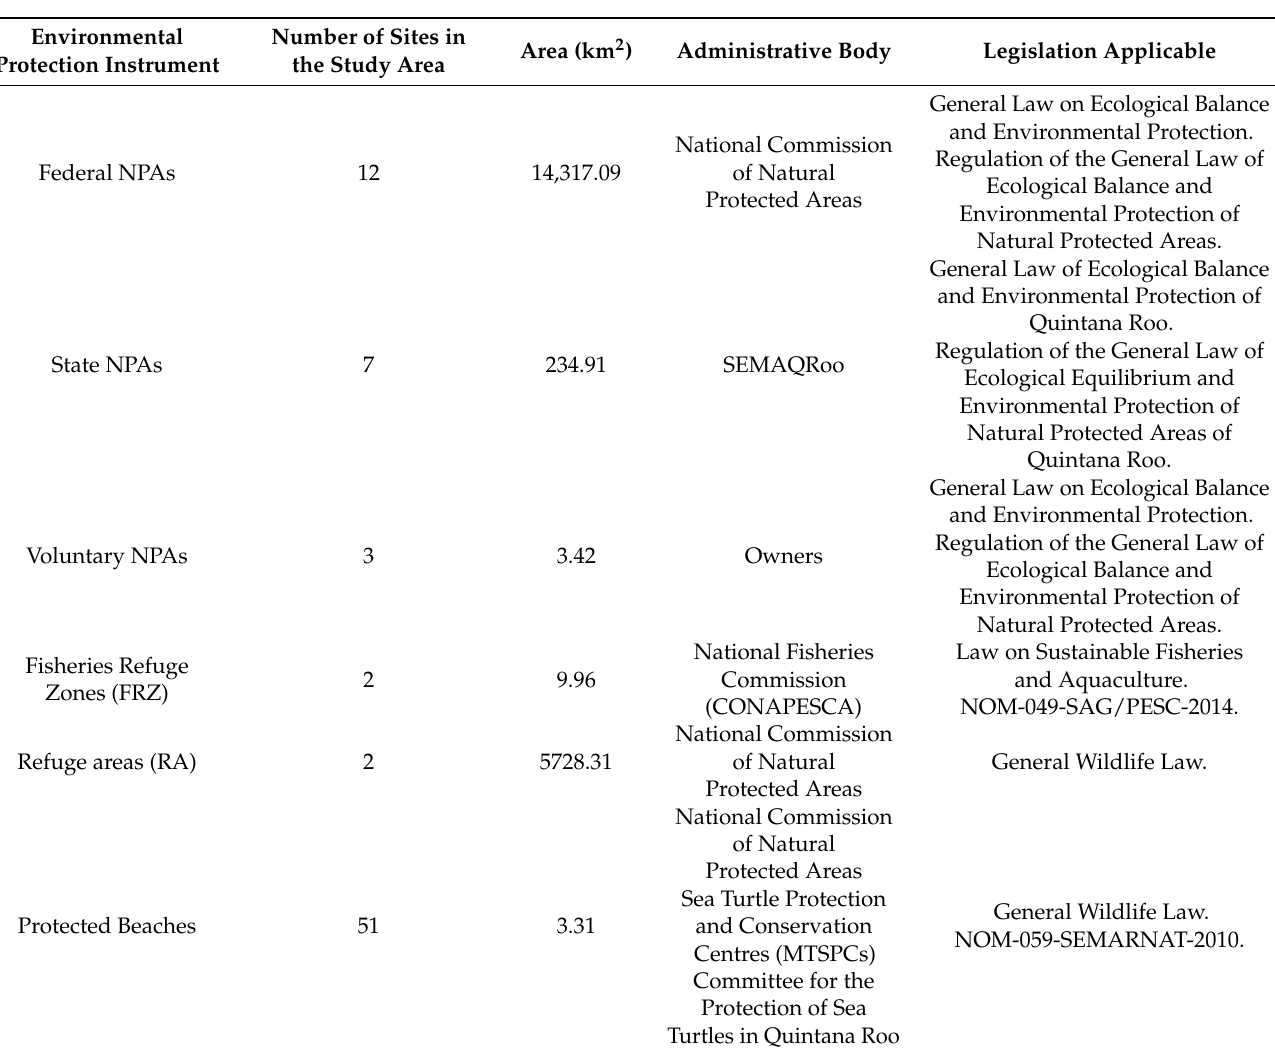
Table 2. Types of Protected